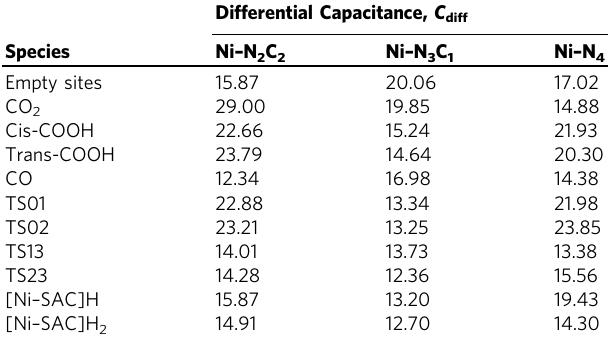
Table 3 Calculated differential capacitance for different intermediates during CO 2 reduction